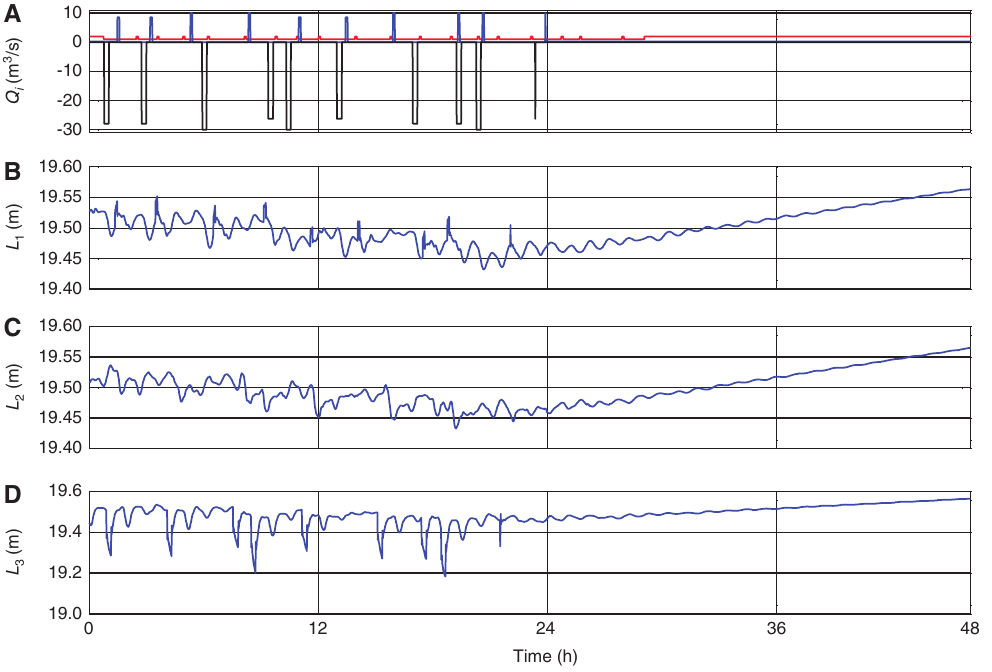
(Blue Line), Aire-sur-la-Lys Q 1